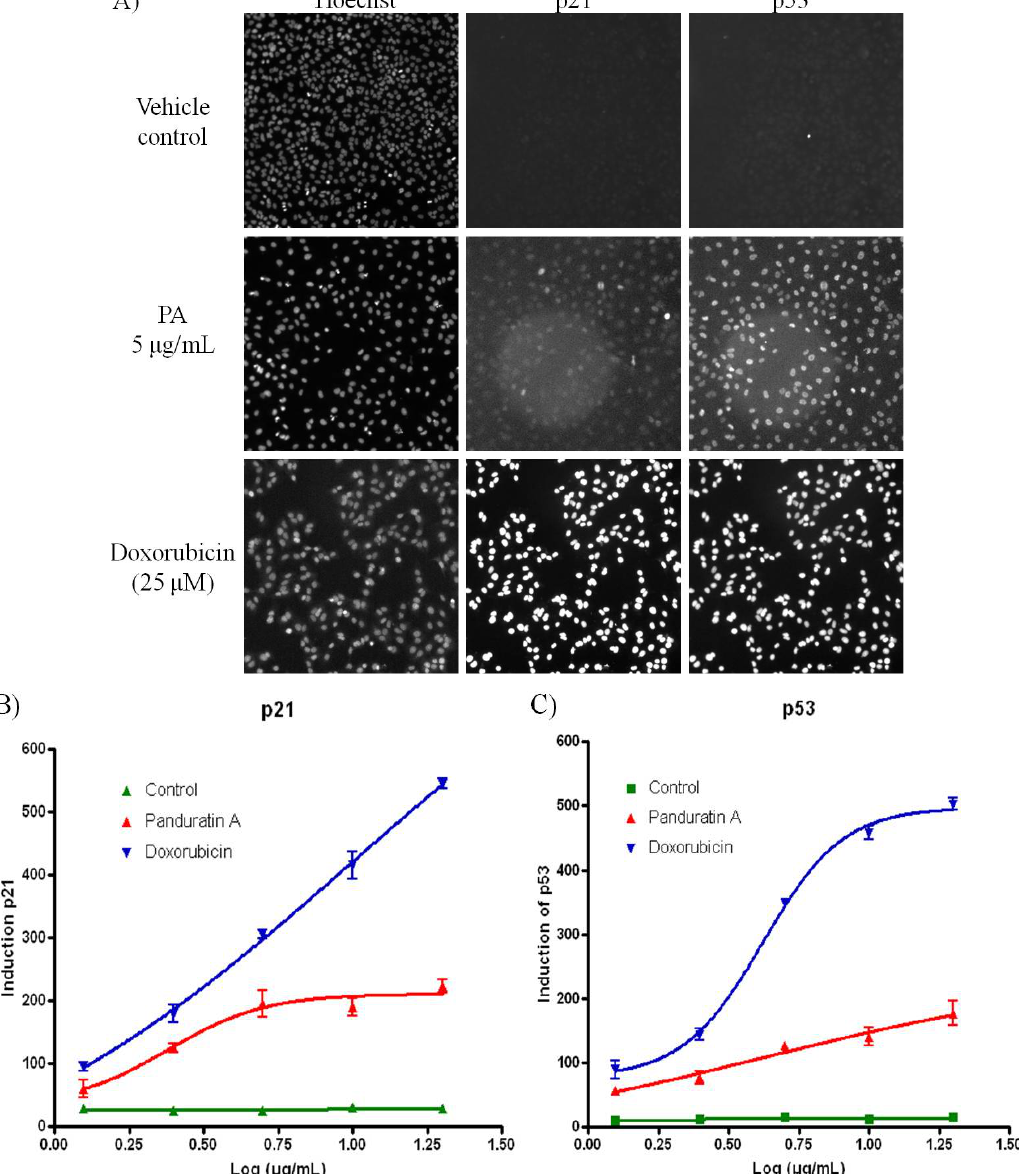
Figure 5. PA induced oxidative stress on A549 cells. ( A ) Fluorescence images acquired on the ArrayScan HCS Reader showing induction of p53 and p21 in the nucleus of A549 cells after 20 h incubation. Doxorubicin was included as positive control. While the untreated cells have minimal p53 or p21 signal, doxorubicin treated cells show bright p53 and p21 labeling in the cell nuclei; ( B ) PA induced p21 was evidenced with increased of the fluorescence signal; ( C ) PA induced p53 was evidenced with increased of the fluorescence